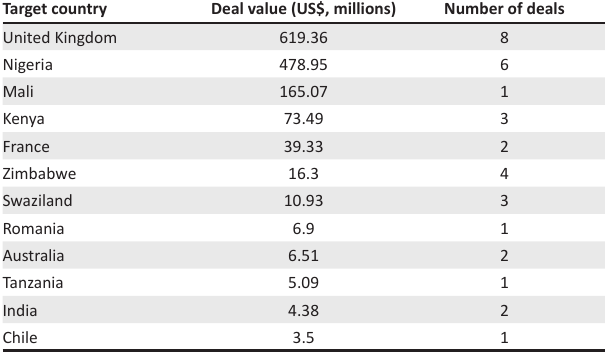
TABLE 12: Agricultural mergers and acquisitions outflows from South Africa by source country, 2003–2014.